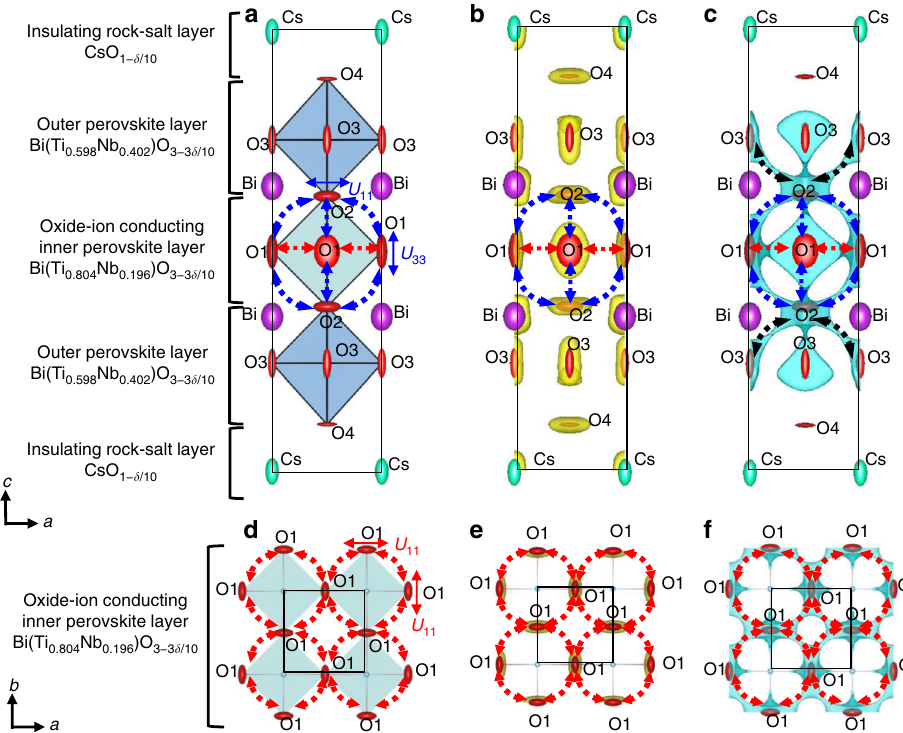
Fig. 4 Crystal structure and oxide-ion diffusion pathway of tetragonal CsBi 2 Ti 2 NbO 9.80(2) at 973 K. a , d Re fi ned crystal structure of CsBi 2 Ti 2 NbO 9.80(2) at 973 K, which was obtained by Rietveld analysis of in situ neutron-diffraction data. b , e Yellow isosurfaces of the neutron scattering length density at 1.0 fm Å − 3 with the structure (973 K). c , f Blue isosurfaces of the bond-valence-based energy for an oxide ion at 0.6 eV for the structure at 973 K. Blue, red, and black dotted lines with arrows denote the possible O1 – O2, O1 – O1, and O2 – O3 diffusion pathways of oxide ion, respectively. The solid lines with arrows in a and d stand for the directions of anisotropic thermal motions of O1 and O2 oxygen atoms. Thermal ellipsoids are drawn at the 50% probability level. Regions of a – c − 1/2 ≤ x , y , z ≤ 1/2 and of d – f − 1/2 ≤ x , y ≤ 3/2, 0 ≤ z ≤ 0.1.